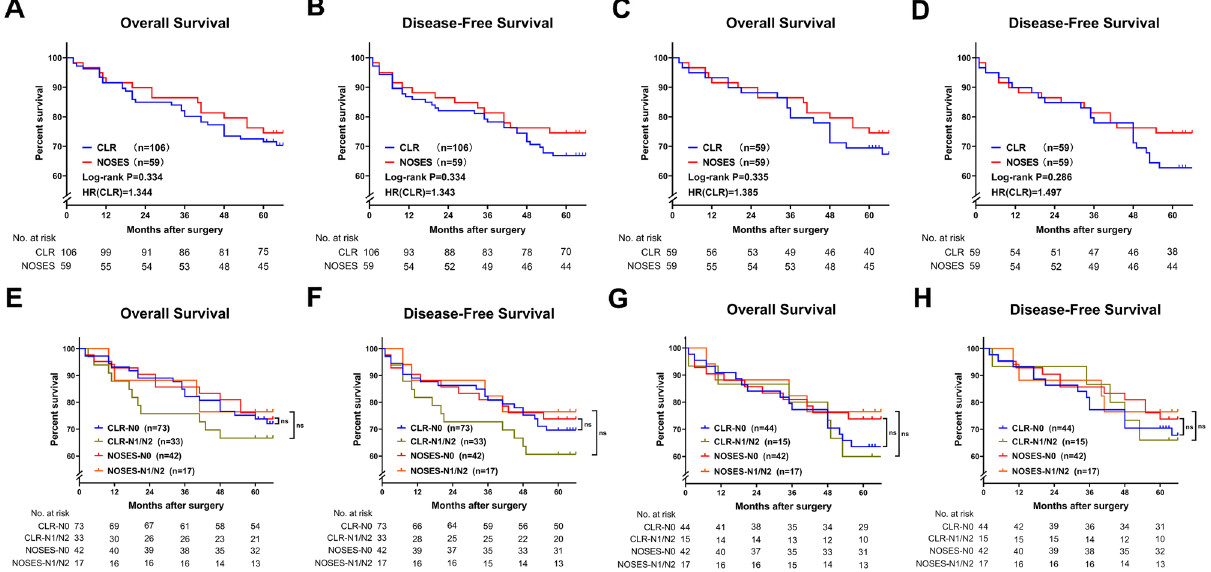
Figure 2. Comparison of long-term curative effect between two groups of patients. ( A – D ) Overall survival and Disease-Free survival between two groups. ( A , B ) Before PSM. ( C , D ) After PSM. ( E – G ) Comparison of overall survival and disease-free survival of patients with different N stages in the two groups. ( E ) overall survival before PSM: Log-rank p (CLR-N0 vs. NOSES-N0) = 0.853, HR(CLR-N0/NOSES-N0) = 1.071, Log-rank p (CLR- N1/N2 vs. NOSES-N1/N2) = 0.151, HR(CLR-N1/N2/NOSES-N1/N2) = 2.164. ( F ) disease-free survival before PSM: Log-rank p (CLR-N0 vs. NOSES-N0) = 0.694, HR(CLR-N0/NOSES-N0) = 1.155, Log-rank p (CLR-N1/N2 vs. NOSES-N1/N2) = 0.276, HR(CLR-N1/N2/NOSES-N1/N2) = 1.839. ( G ) Overall survival after PSM: Log-rank p (CLR-N0 vs. NOSES-N0) = 0.549, HR(CLR-N0/NOSES-N0) = 1.271, Log-rank p (CLR-N1/N2 vs. NOSES-N1/ N2) = 0.371, HR(CLR-N1/N2/NOSES-N1/N2) = 1.765. ( H ) disease-free survival after PSM: Log-rank p (CLR-N0 vs. NOSES-N0) = 0.378, HR(CLR-N0/NOSES-N0) = 1.408, Log-rank p (CLR-N1/N2 vs. NOSES-N1/N2) = 0.384,